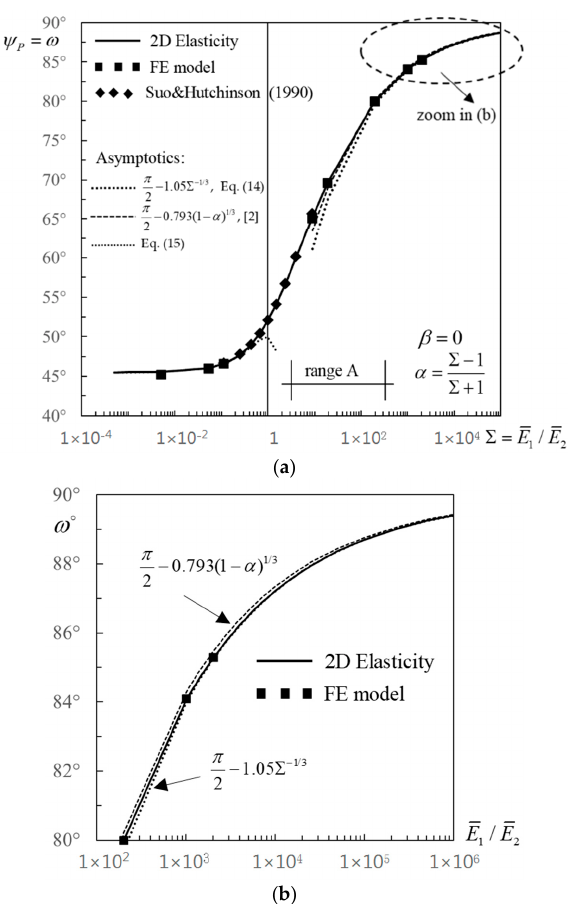
Figure 4. ( a ) Mode mixity phase angle ψ P = ω as a function of Σ = E 1 / E 2 . The analytical results are compared with numerical results and with the asymptotics derived here and in [2]. ( b ) The zoom for large values of Σ = E 1 / E 2 . Range A in ( a ) is the interval where the asymptotics and expansions in Equations (14)–(16) do not ensure uncertainties below 0.2 ◦